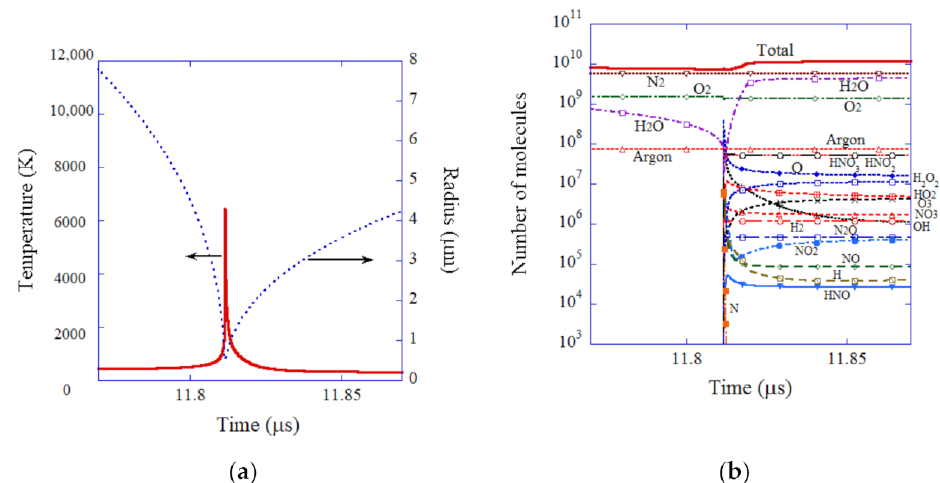
Figure 4. The results of the numerical simulation for an initial air bubble as a function of time at around the end of the violent bubble collapse for 0.1 µ s [40]. ( a ) The bubble radius and the temperature inside a bubble. ( b ) The number of molecules inside a bubble. Copyright 2005, with permission of AIP